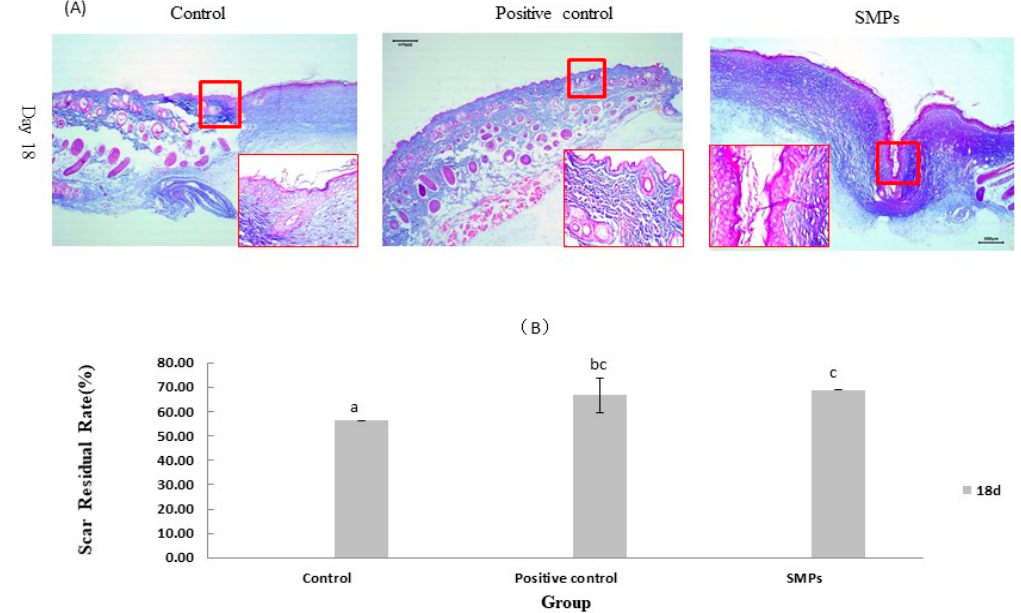
Figure 6. Effects of SMPs on collagen bundles and epithelialization. ( A ) Representative images of Masson stained wound sections (10× and 40×). Sliced blue indicates collagen, red indicates cytoplasm and muscle fibers. ( B ) Scar residual rate. Different and same letters within the same row indicate significant ( p < 0.05) and insignificant different ( p > 0.05), respectively.